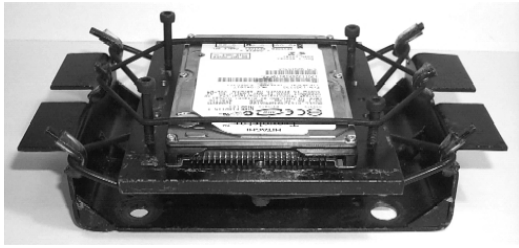
Fig. 15. Vibration isolator system